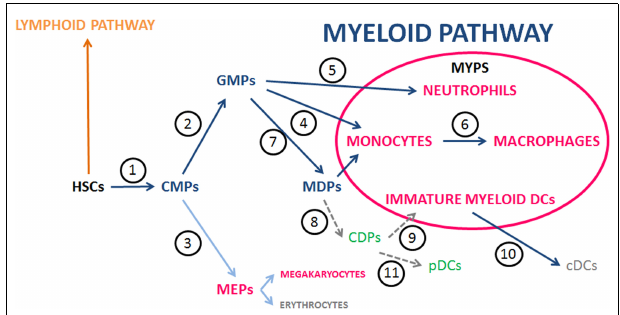
FIGURE 1 | Main steps and players of myelopoiesis in the context of the MYPS. Graph depicting one interpretation of the still evolving view of the myelopoiesis pathways (blue arrows) associated with the poiesis of the members of the MYPS in mice and humans.This interpretation takes into consideration recent publications whose references are given below (see also the reviews Friedman, 2002; Iwasaki and Akashi, 2007;Varol etal., 2009; Geissmann etal., 2010b). HSCs give rise to CMPs (1) (Akashi etal., 2000; Manz etal., 2002). CMPs originate GMPs (2) and MEPs (3) (Akashi etal., 2000; Manz etal., 2002). GMPs differentiate into Monocytes (4), Eosinophils, Basophils, Mast cells, and Neutrophils (5) (Akashi etal., 2000; Iwasaki and Akashi, 2007) and MDPs (7) (Iwasaki and Akashi, 2007). An alternative to the view that MDPs originate from GMPs considered that MDPs would directly derive from CMPs; Fogg etal., 2006). Monocytes mature into Macrophages (6) (van Furth etal., 1973; Akashi etal., 2000; Sunderkotter etal., 2004; Fogg etal., 2006).The pathways to myeloid DCs include MDPs [originated from GMPs (7); Iwasaki and Akashi, 2007] that differentiate into CDPs (8) (Onai etal., 2007; Liu etal., 2009) and these give rise to Immature myeloid DCs (9) [that originate cDCs (10)], and pDCs (11) (Naik etal., 2006, 2007).The members of the MYPS are highlighted in bold. MYPS, myeloid phagocyte system; HSCs, hematopoietic stem cells; CMPs, common myeloid precursors; GMPs, granulocyte/macrophage precursors; MEPs, megakaryocyte/erythrocyte progenitors; MDPs, macrophage/DC progenitors; CDPs, common DC progenitors; cDCs, conventional (or classic) myeloid DCs; pDCs, plasmacytoid